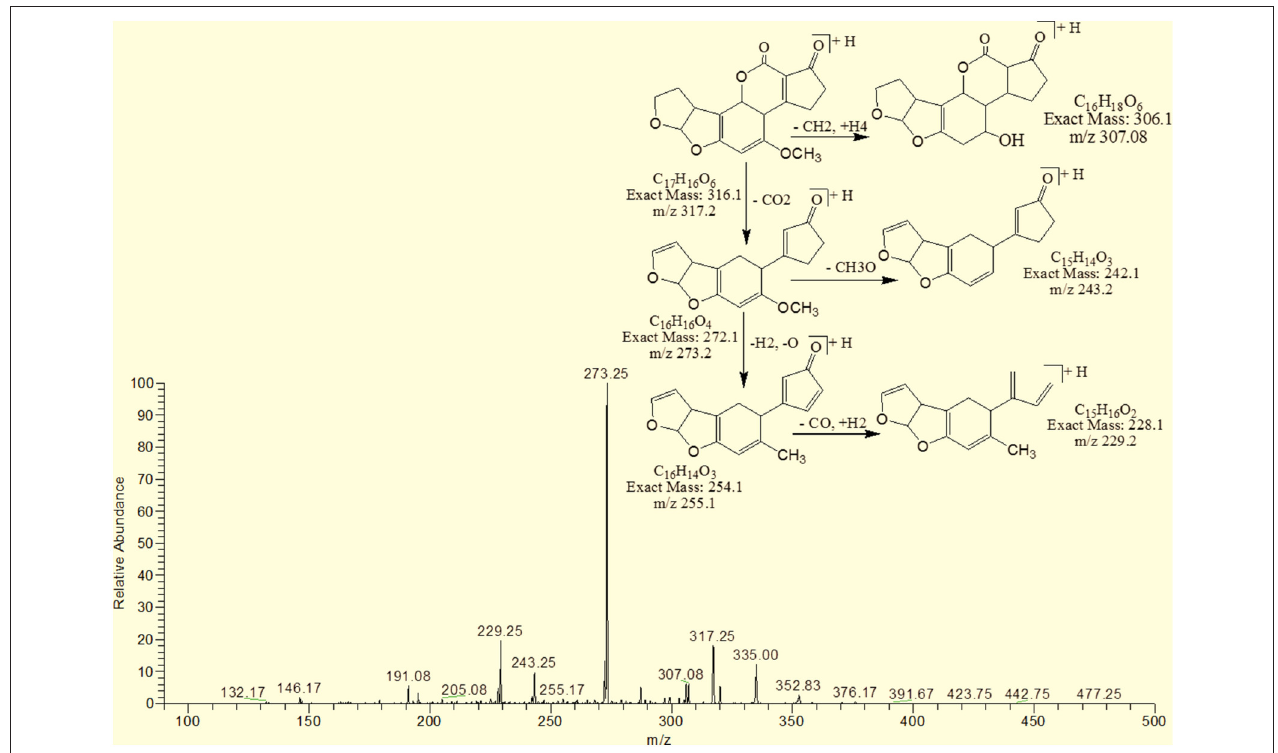
FIGURE 12 | MS/MS spectra and fragmentation pathway of degradation product with